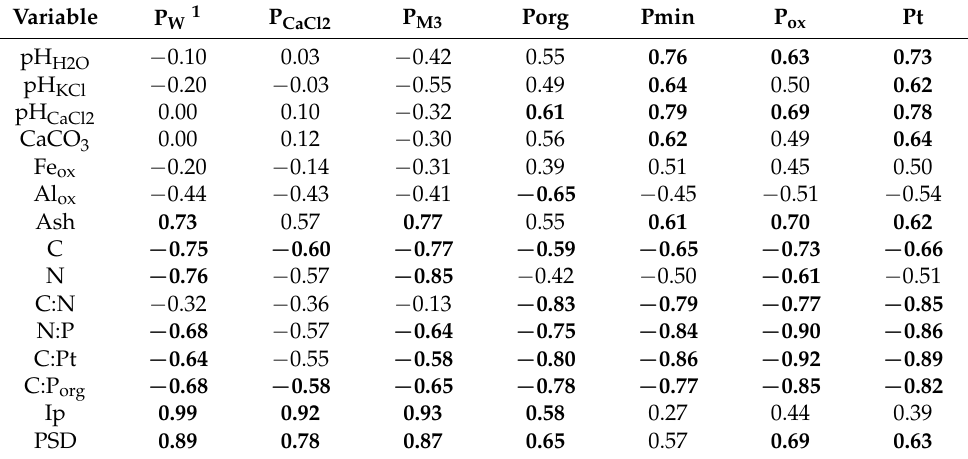
Table 6. Correlation coefficients for selected basic soil properties and calculated parameters, and P forms in organic horizons of soils under study. Correlation coefficients significant at p < 0.05 are shown in